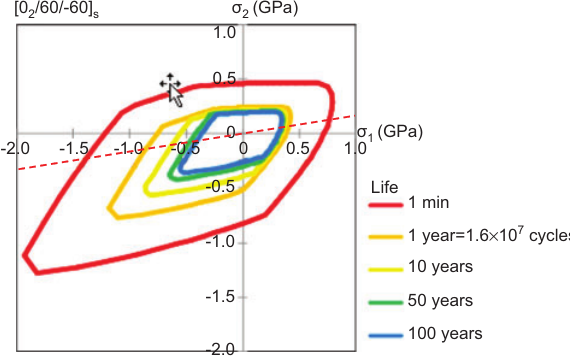
Figure 20 Fatigue failure envelope in σ /60/-60] laminate (results generated by life for π /3 [0 2 s